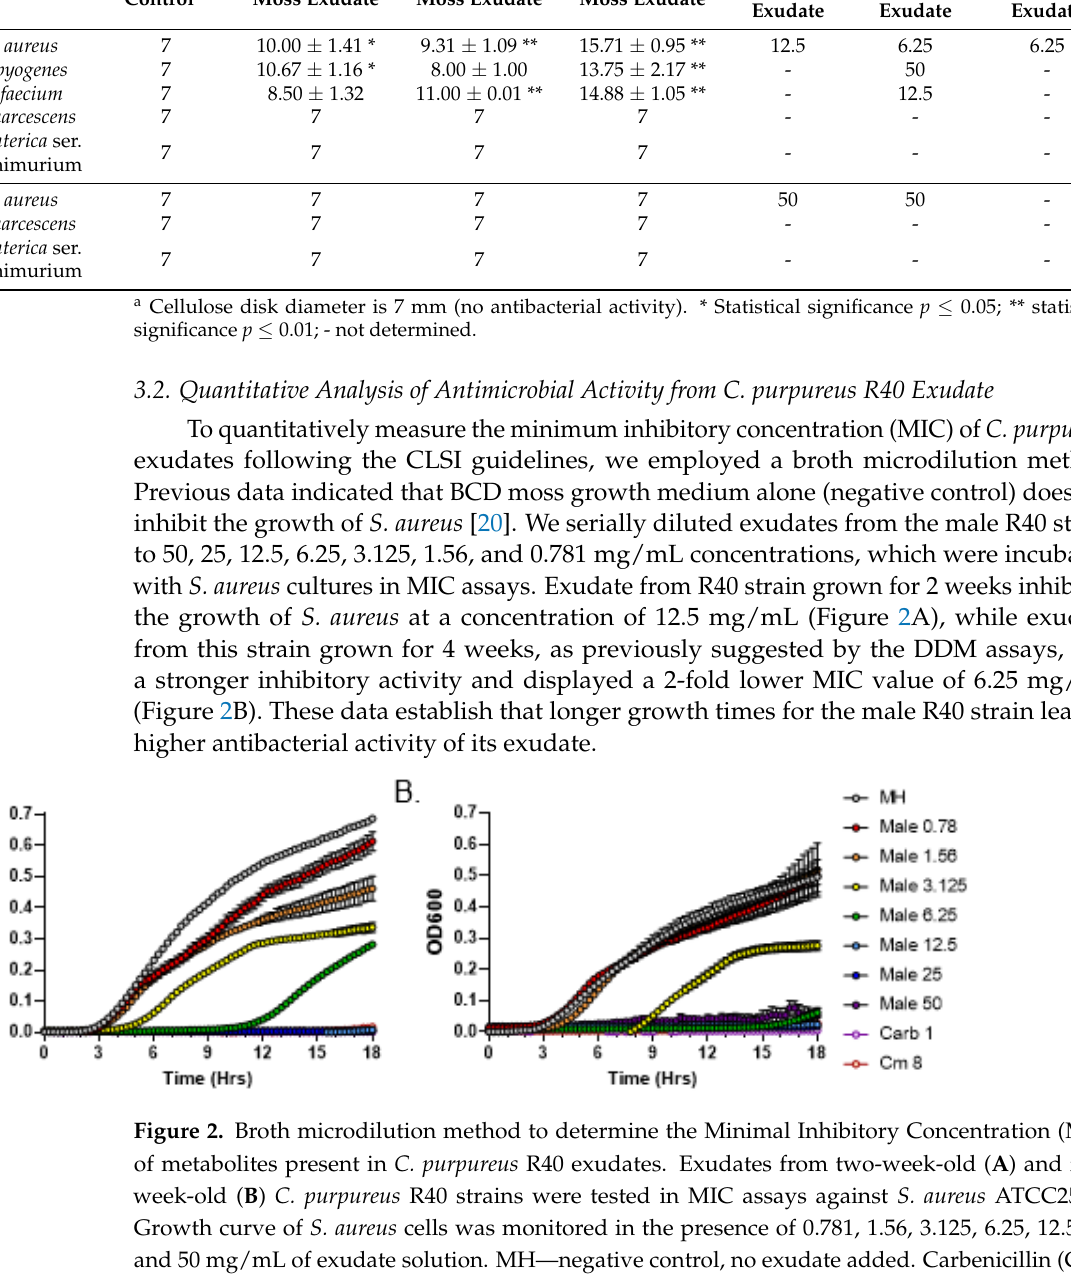
Figure 3. Broth microdilution method to determine the Minimal Inhibitory Concentration (MIC) of metabolites present in C. purpureus GG1 exudates. Exudates from two-week-old ( A ) and four-week- old ( B ) C. purpureus GG1 strains were tested in MIC assays against S. aureus ATCC25923. Growth curve of S. aureus cells was monitored in the presence of 0.781, 1.56, 3.125, 6.25, 12.5, 25, and 50 mg/mL of exudate solution. MH — negative control, no exudate added. Carbenicillin (Carb, 1 µg/mL) and chloramphenicol (Cm, 8 µg/mL) treatments were used as positive controls for S. aureus growth inhibition. We next tested the most potent exudate from 4-week-old R40 strain in MIC assays against two other Gram-positive bacteria, Streptococcus pyogenes and Enterococcus faecium . While R40 exudates were indeed able to inhibit the growth of both bacteria, the MIC val- ues were different. Specifically, the MIC value for S. pyogenes was 50 mg/mL (Figure 4A), while for E. faecium it was 4 times lower, 12.5 mg/mL (Figure 4B). These data indicate that both S. aureus and E. faecium are much more sensitive than S. pyogenes to the bioactive metabolites present in C. purpureu s R40 exudates. Nevertheless, our quantitative MIC data